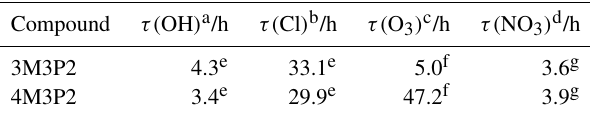
Table 6. Estimated tropospheric lifetimes for the studied α , β -unsaturated ketones. The lifetimes were calculated using the following concen- trations: a global mean of 1 × 10 6 moleculescm − 3 (Bloss et al., 2005), b 12h average of 3 × 10 4 moleculescm − 3 (Wingenter et al., 1996), c 24h average of 7 × 10 11 moleculescm − 3 (Logan, 1985), and d 12h average of 5 × 10 8 moleculescm − 3 (Atkinson, 1991). Rate coefficients were taken from: e this work, f Illmann et al. (2021a), and g Canosa-Mas et al. (2005). Compound τ( OH ) a